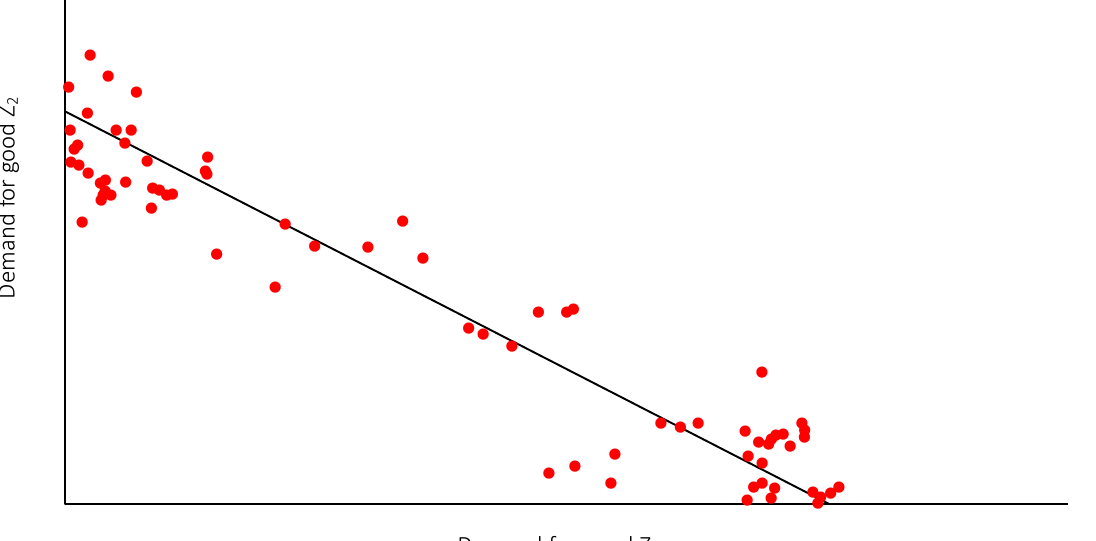
Figure 1а. Schematic illustrations of demand for two public goods, if they are